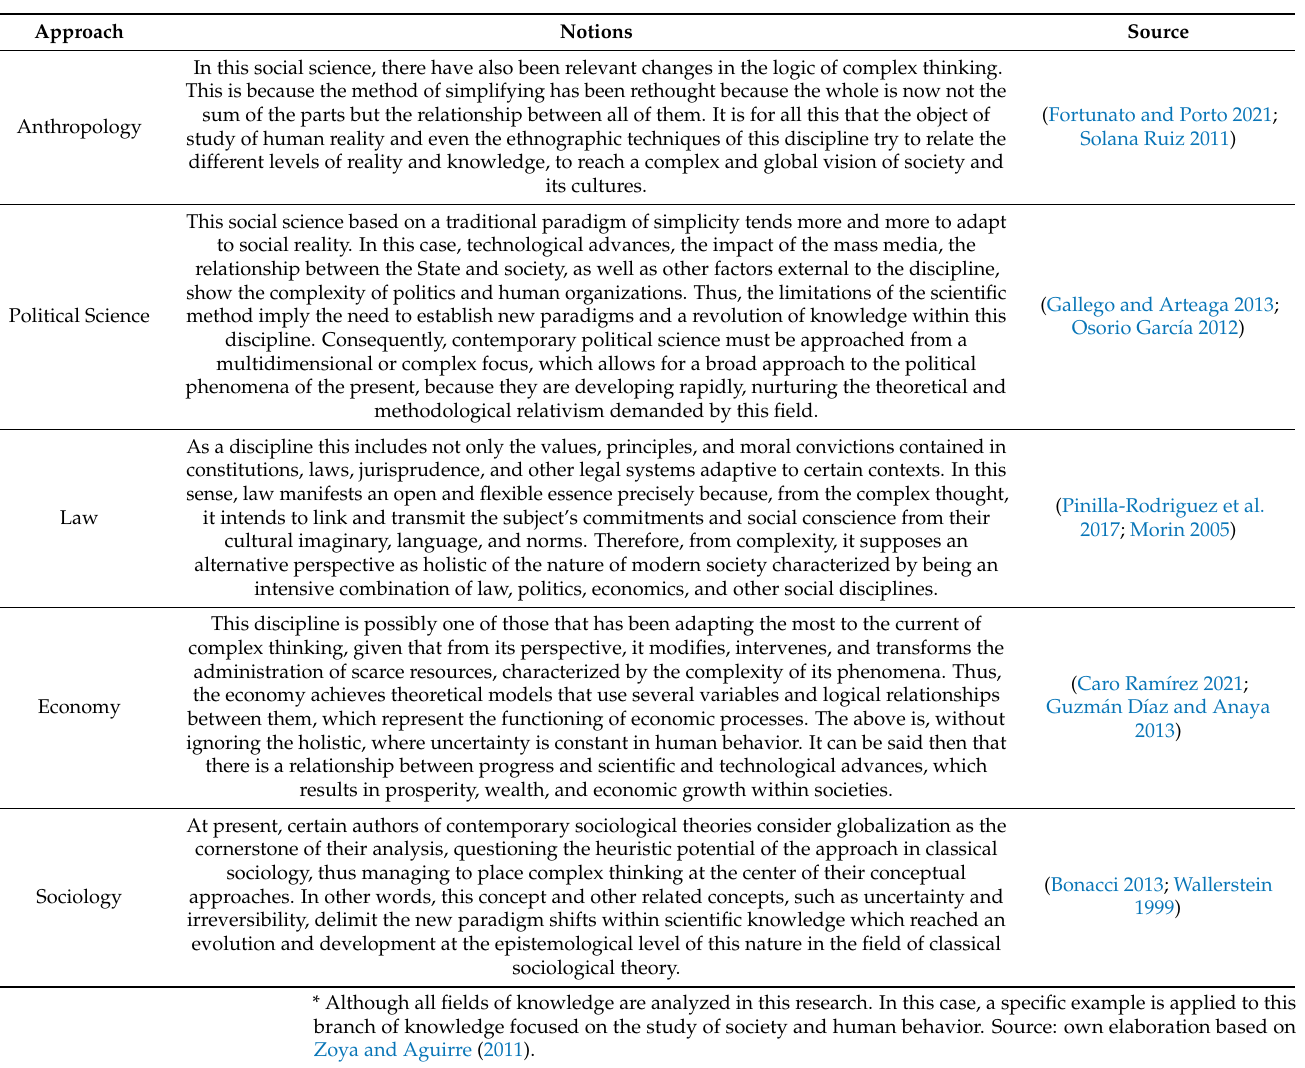
Table 1. Notions of complex thinking in some social science approaches